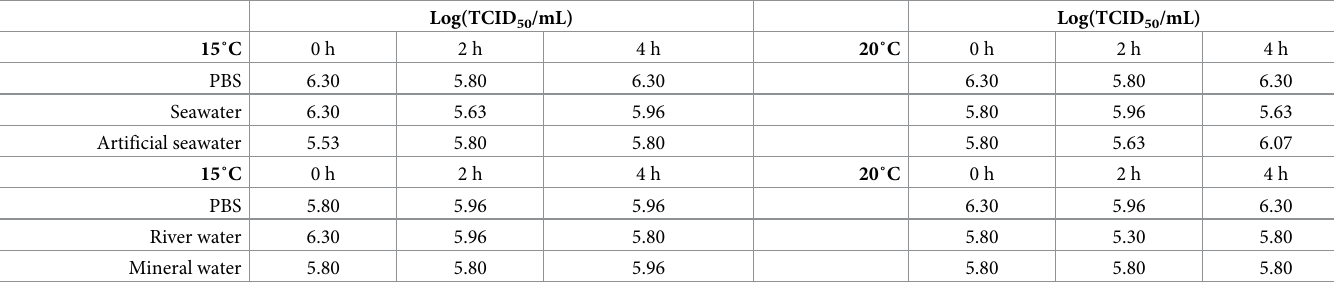
Table 1. The short-term stability of PRCV in natural and artificial salt- and freshwater media.